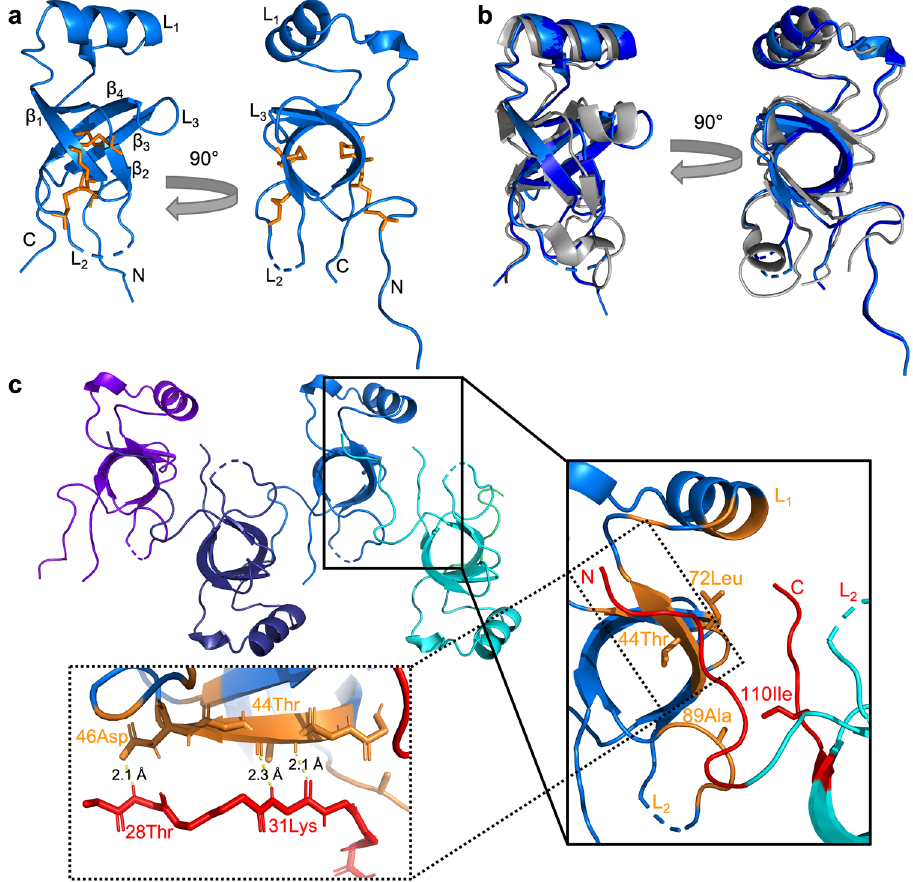
Figure 1. X-ray crystal structure of SC16. ( a ) A ribbon representation of SC16 crystallized in the C222 1 space group (PDB ID: 7S86). Two different orientations are shown and the beta strands (β 1 − β 4 ), and loops (L 1 − L 3 ) are indicated. Conserved disulphide bonds are highlighted as orange sticks. ( b ) A superposition of SC16 crystalized in the C222 1 (light blue) and P2 1 2 1 2 (PDB ID: 7S7S; dark blue) space groups with the NMR- derived structure of SC16 20 (PDB ID: 2NBH; grey). ( c ) Ribbon representation of 4 symmetrically related SC16 molecules (coloured differently) in the C222 1 SC16 crystal. The inset highlights a putative biological contact spanning 606.80 Å 2 that involves portions of L 1 , L 2 , and β-barrel structure from one molecule (coloured cyan and orange) and the N- and C-termini of a second molecule (coloured light blue and red). Residues flagged by EPPIC as participating in close contacts are highlighted orange or red, labelled, and drawn as sticks. The second inset illustrates the association between the N-terminal tail of one SC16 molecule with the β 1 strand of another. Putative hydrogen bonds are indicated with yellow